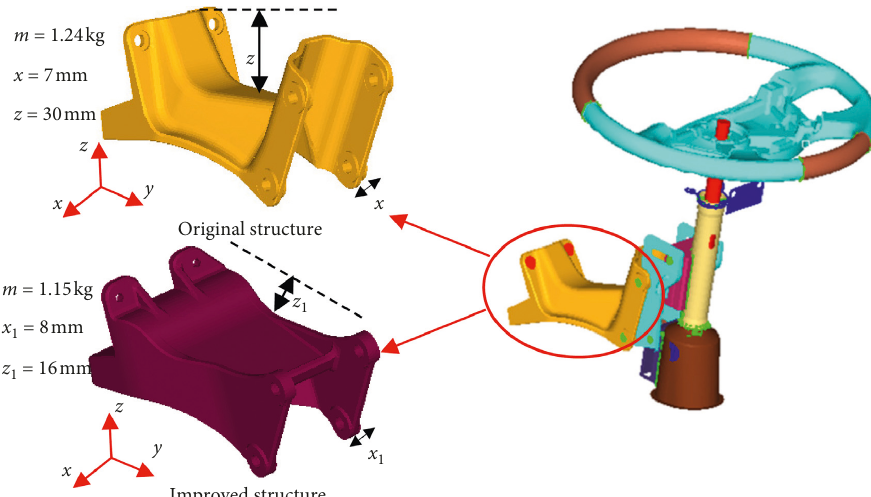
Figure 20: Comparison of the improved designs of the steering fixed support.